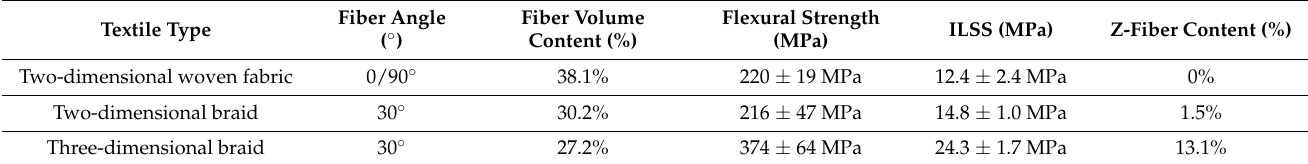
Table 6. Properties of various textile-reinforced OFCs with Nextel TM